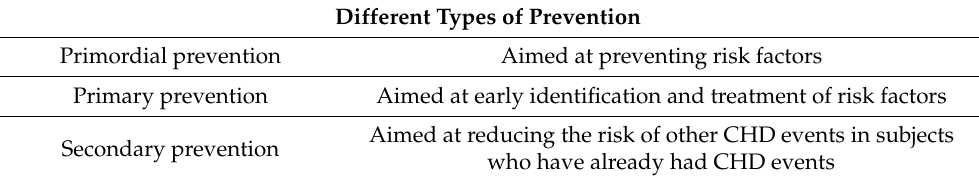
Table 1. Types of prevention.